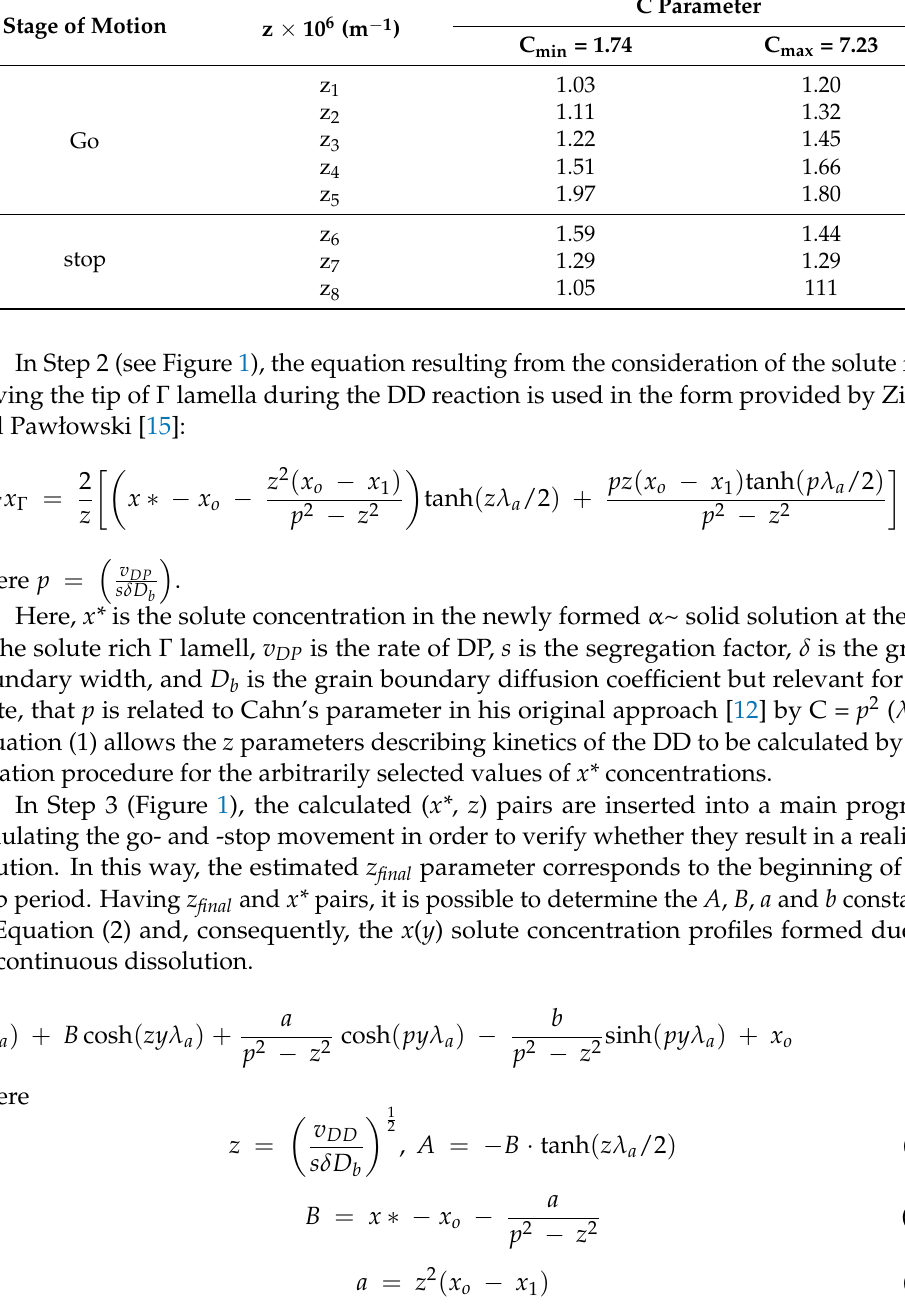
Table 1. Values of z parameters for one cycle of go- and -stop motion and two extreme C parameters. Stage of